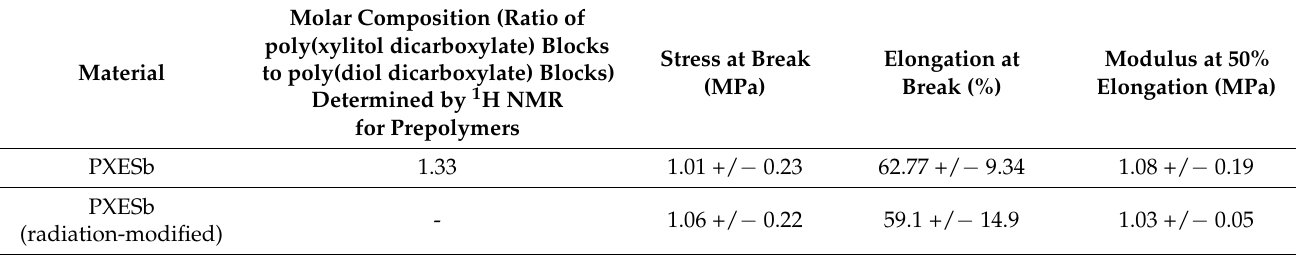
Table 1. Properties and molar composition of poly(xylitol dicarboxylate-co-diol dicarboxylate) pre and post e-beam treatment.